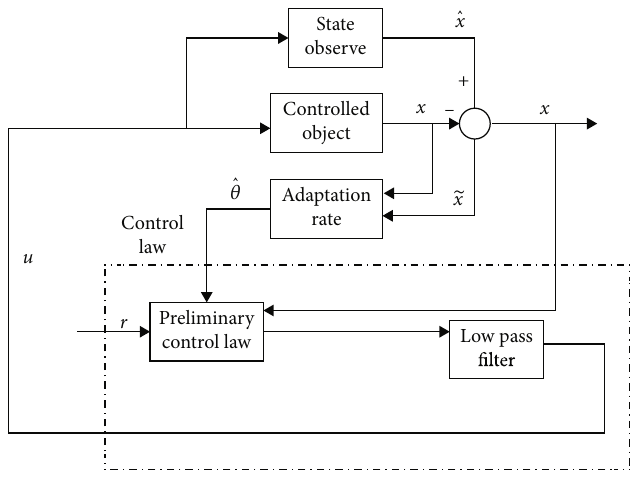
Figure 3: L1 adaptive control system